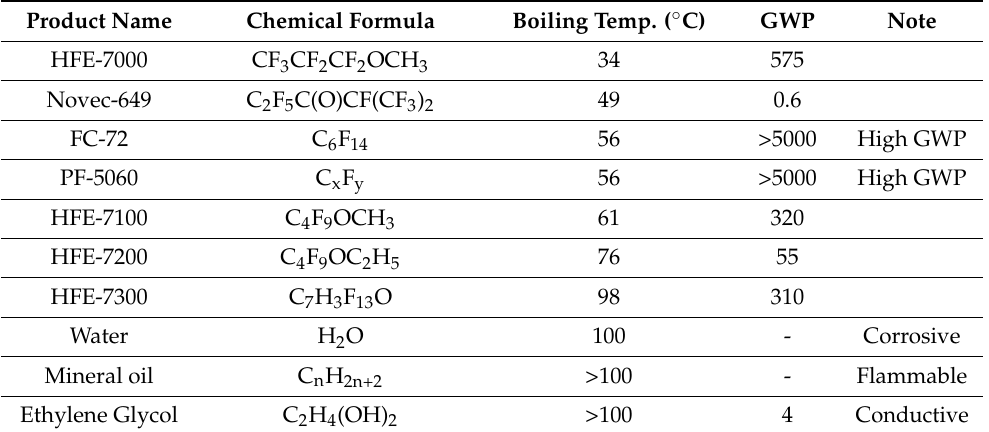
Table 1. Various liquids used for cooling and their boiling temperatures and